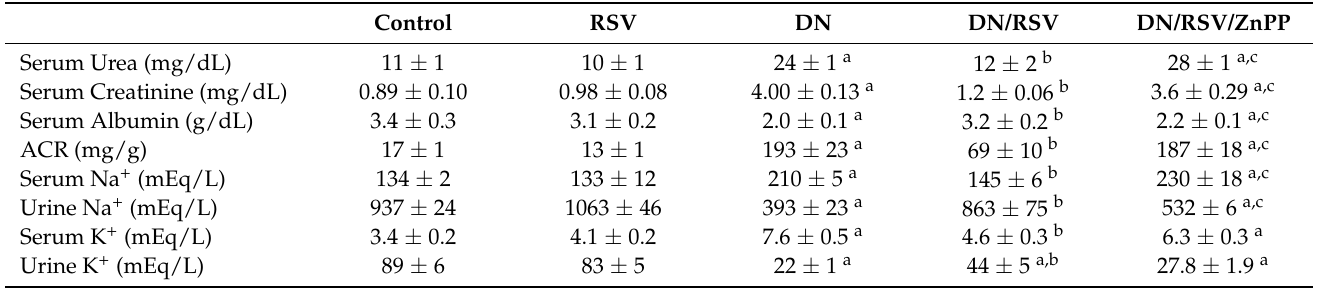
Table 2. Effect of rosuvastatin (RSV) on kidney functional parameters in diabetic nephropathy (DN) in rats.